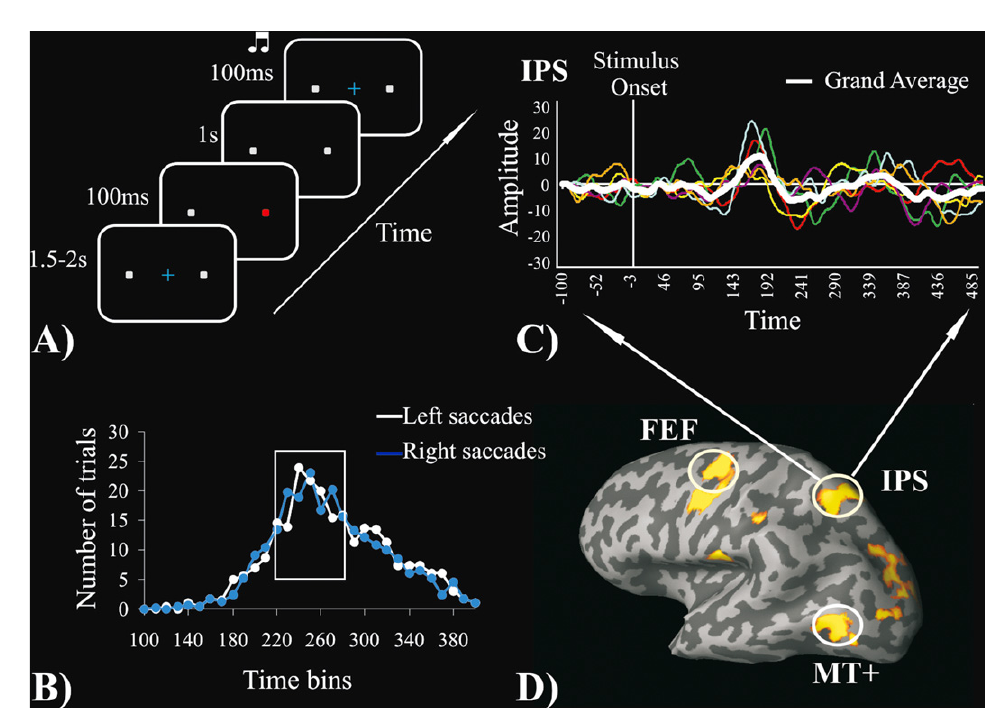
Figure 1. (A) MEG experimental paradigm. (B) Group-average frequency distribution of trials by SRT; white line = leftward saccades; blue line = rightward saccades. The white rectangle indicates the time interval selected for the single interval analysis in 4 out 6 subjects. (C) An example of the MEG source wave- forms obtained by fMRI-constrained dipoles corresponding to the left IPS. Colored lines represent different subjects and the white line represents the grand average. (D) The fMRI group map, obtained by contrasting saccadic task periods with rest periods, is superimposed on the infl ated cortex of one participant. White circles indicate the three ROIs for the left